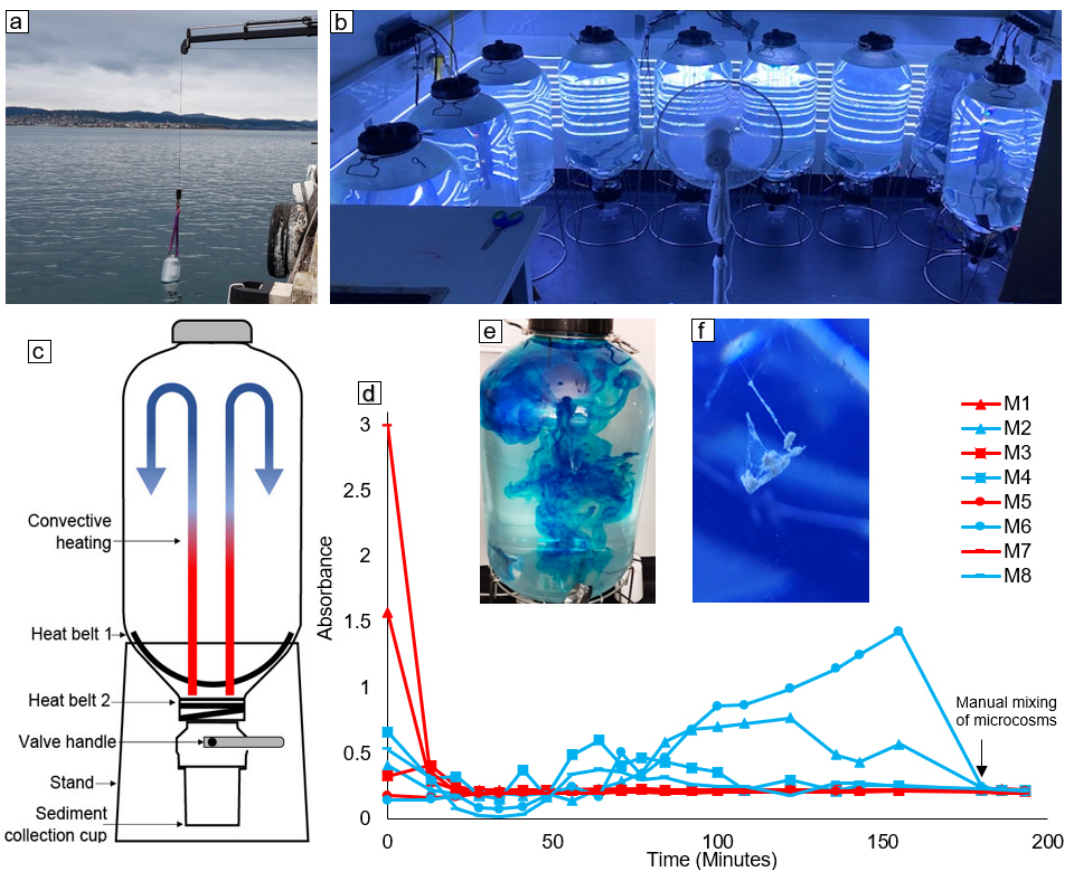
Figure 1. (a) Method and location of microcosm filling, (b) experimental setup, (c) schematic diagram of the microcosms used in this study, (d) results of the convective mixing test (microcosms with convective mixing are indicated by red lines and no-convection microcosms indicated by blue lines), (e) microcosm with dye addition for assessment of convective mixing, and (f) formation of an aggregate within a